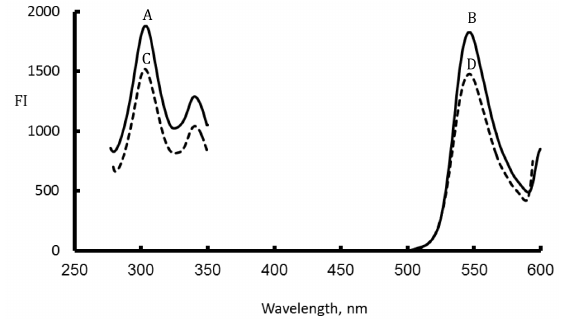
Figure 4: Fluorescence spectra for eosin Y (3.7 ´ 10 - 6 M, pH 3.5): (A,B) excitation and emission spectra for eosin Y, (C,D) excitation and emission spectra for eosin Y after its reaction with cyclobenzaprine (1.5